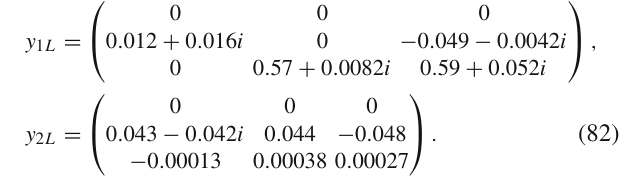
Thecouplingcombination ( y 22